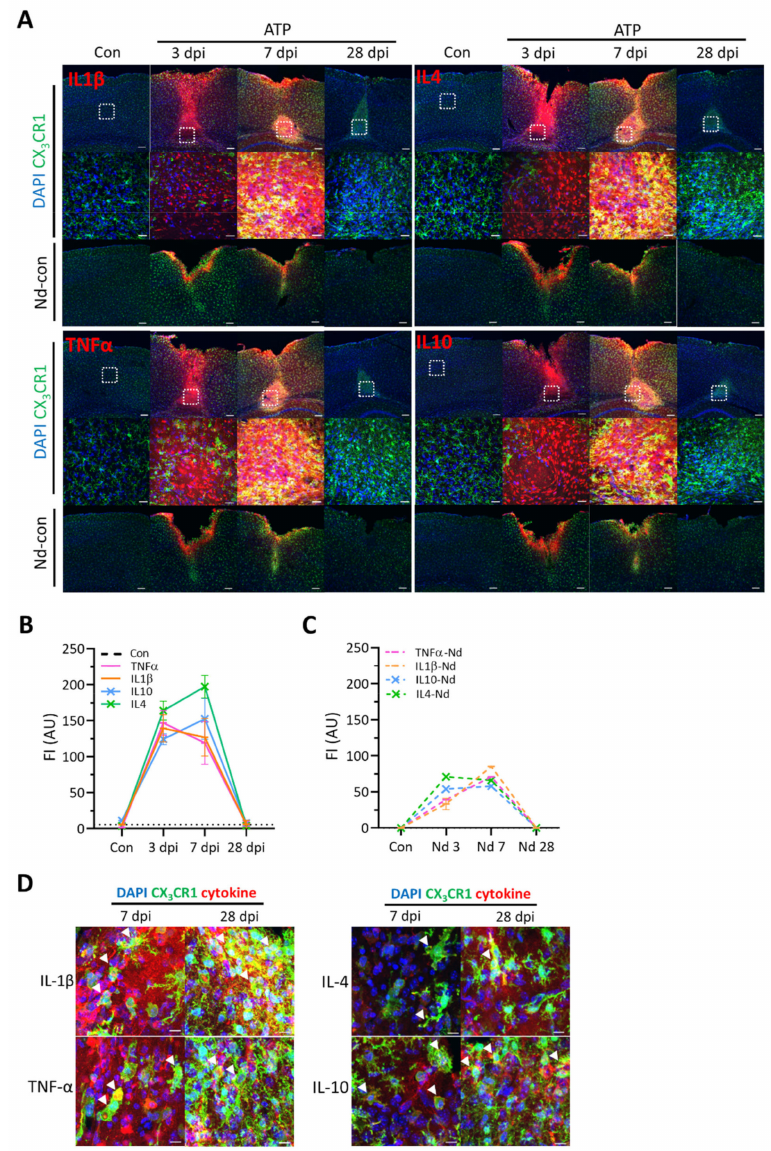
Figure 2. Cytokine expressions after ATP injection and their co-labeling with CX 3 CR1-GFP (+) cells. ( A ). Top : Representative images of immunohistochemistry of cytokines, IL-1 β , TNF- α , IL-4, and IL10, after ATP injection. Middle : Magnification of white square area in Top . DAPI (blue), cytokine (red), and CX 3 CR1 (green). Scale bars , 100 µ m ( Top ) and 20 µ m ( middle ). Bottom : Needle-control images of each cytokines. ( B ). Quantification of the fluorescence intensity of each cytokine at days after ATP injection. Con (black dash line) indicates the intensity of each cytokines in control tissues. ( C ). Quantification of fluorescence intensity of each cytokines at days after needle stab wound. ( D ). Representative images of the co-labeling (white triangles) of each cytokine with activated CX3CR1-GFP (+) microglia in the core of 7 dpi and 28 dpi tissues. Scale bar , 10 µ